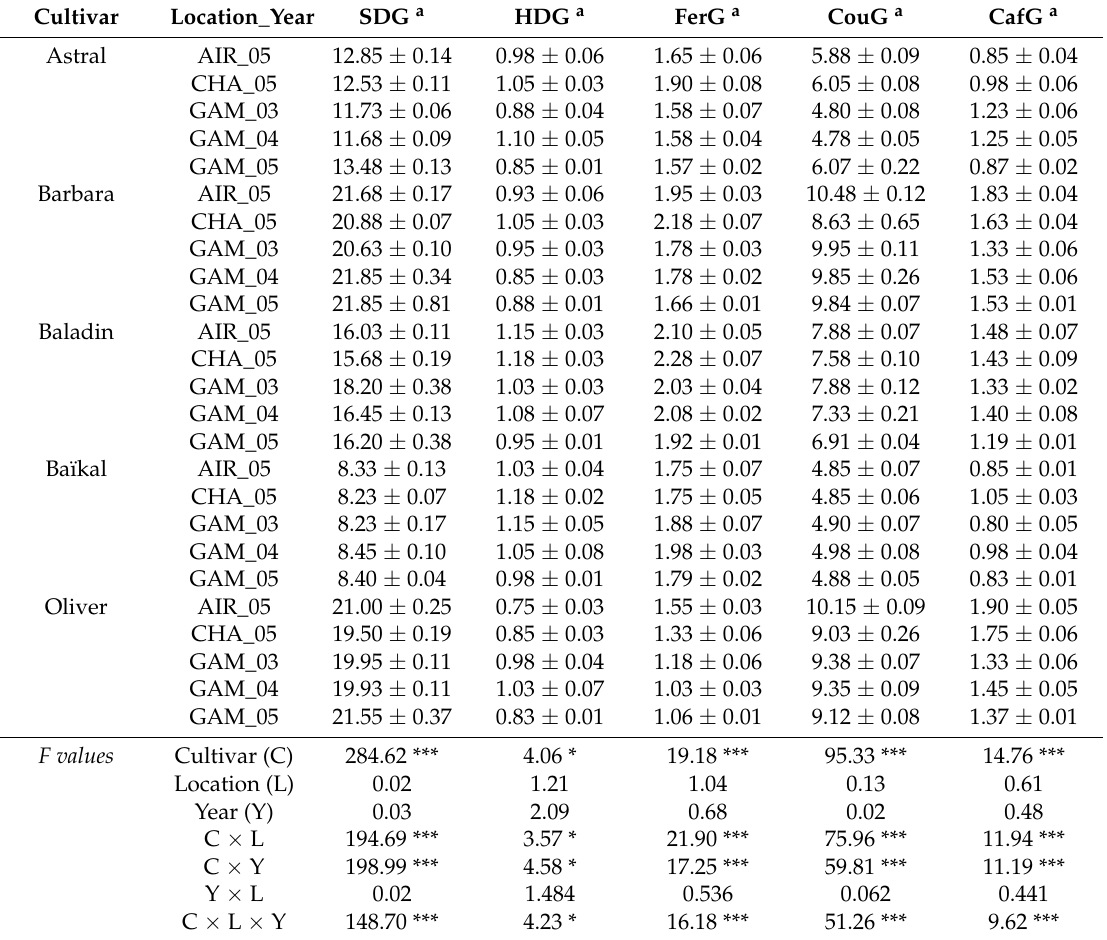
Table 1. Influence of the cultivar (C), cultivation site (L), and year (Y) on the accumulation of the main constituents of the lignan macromolecule in